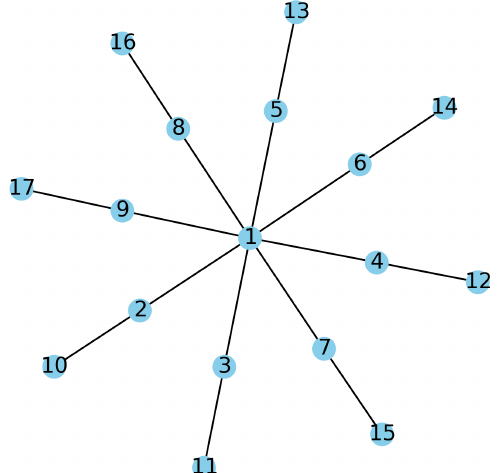
Figure 2. The star-sharp network proves that the inverse propositions of Theorems 1 and 2 do not hold. The star-sharp network consists of 17 nodes and 16